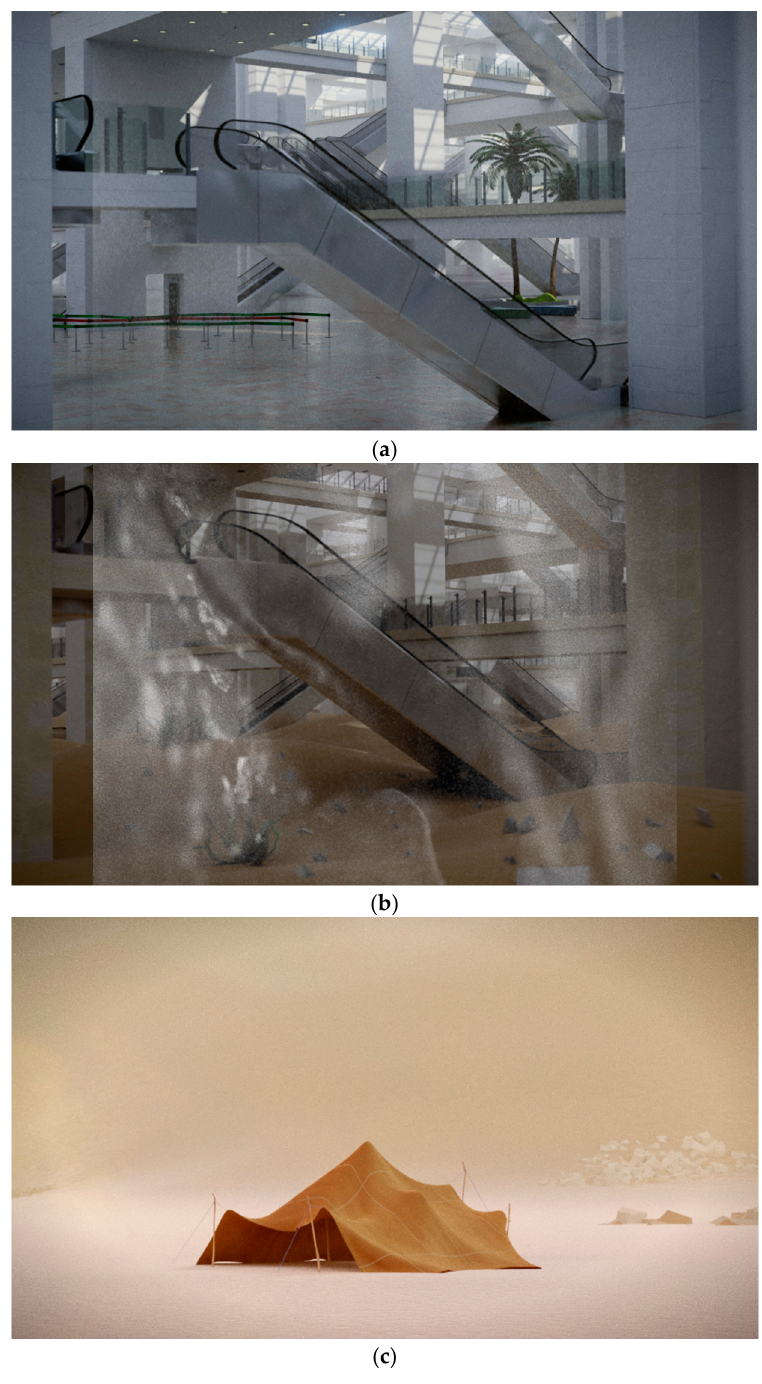
Figure 6. Scene 1 ( a ), Scene 2 ( b ), and Scene 3 ( c ). Images from Ecdysis courtesy of Thomas Léon. (To see the preview: https://vimeo.com/249929364).